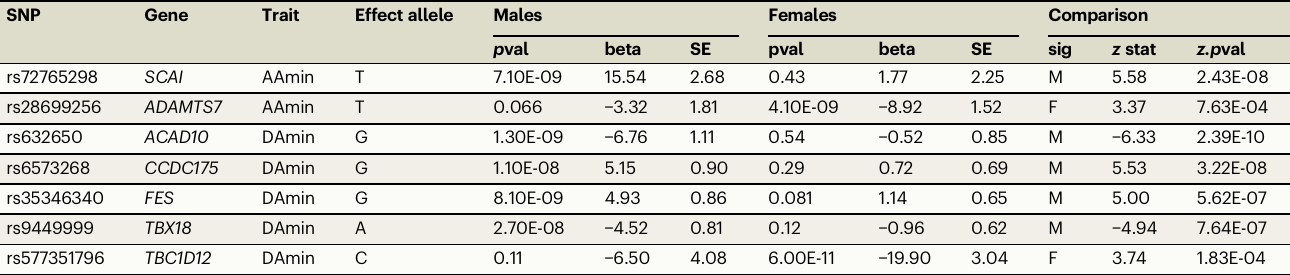
Table 2 | Lead SNPs at sex-speci fi c loci SNP Gene Trait Effect